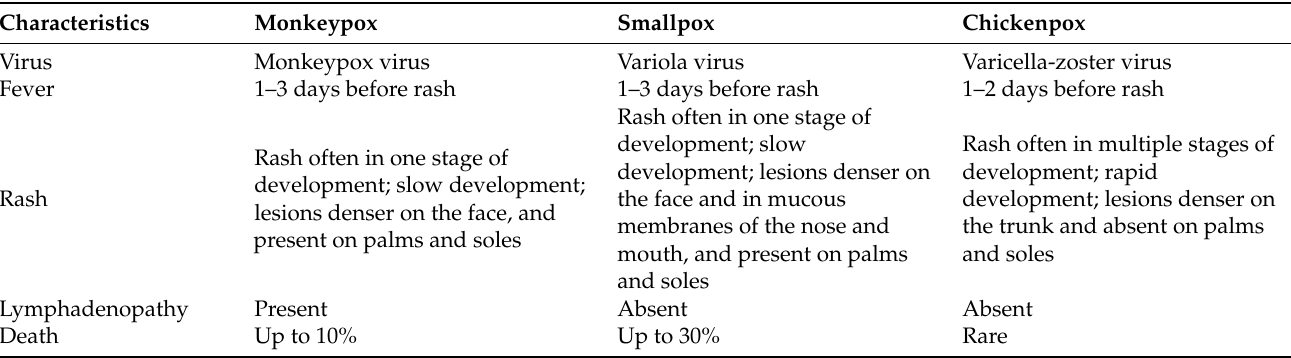
Table 4. Comparison of monkeypox clinical presentation and death rates with smallpox and chicken- pox (adapted from